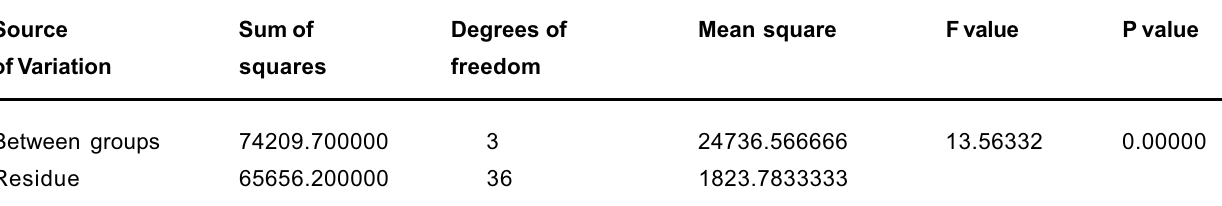
TABLE 2- Analysis of